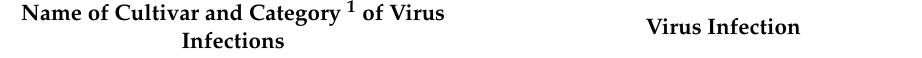
Table 1. Sanitary status of selected vines from vineyards selected for the establishment of in vitro meristem culture determined by